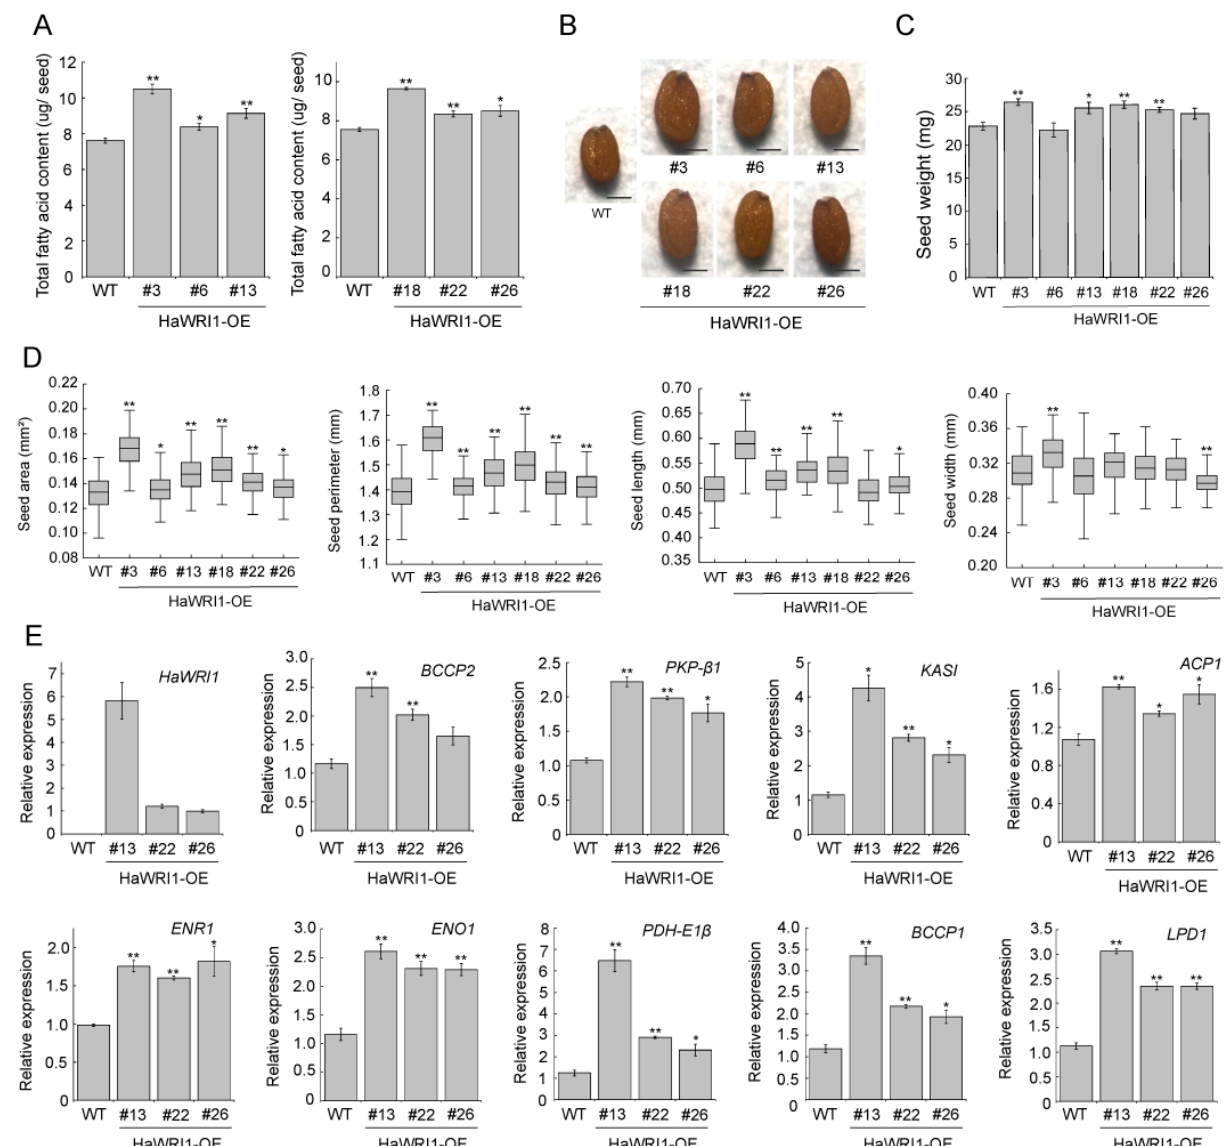
Figure 4. Functional analysis of transgenic Arabidopsis overexpressing HaWRI1 (HaWRI1-OE). ( A ) Fatty acid content of seeds of Arabidopsis HaWRI1-OE lines. Results are shown as means ± SE ( n = 3–4). ( B ) Mature dry seeds of WT and HaWRI1-OE lines. Scale bar is 200 µ M. ( C ) Quantitative analysis of seed mass WT and HaWRI1-OE lines. Seed mass was attained by measuring 100 seeds per sample, and results are shown as means ± SE ( n = 4–5). ( D ) Quantitative analysis of seed size of WT and HaWRI1-OE lines. Seed size is denoted by seed area, perimeter, length, and width with box plots displaying medians (lines), interquartile ranges (boxes) and 1.5 × interquartile ranges (whiskers) of WT and HaWRI1-OE lines ( n = 100). “*” and “**” indicate significant differences ( p < 0.05 and p < 0.01, respectively, Student’s t -test) between WT and HaWRI1-OE lines. ( E ) Pooled siliques (10 DAF) from WT and HaWRI1-OE lines were used for the assay. Transcript levels of various WRI1 target genes ( BCCP2 , PKP- β 1 , ACP1 , KASI , ENR1 , ENO1 , PDH-E1 β , LPD1 , BCCP1 ) were measured by qRT-PCR. Results are shown as means ± SE ( n = 3). “*” and “**” indicate significant differences ( p < 0.05 and p < 0.01, respectively, Student’s t -test) between WT and HaWRI1-OE lines in terms of expression of WRI1 target genes.